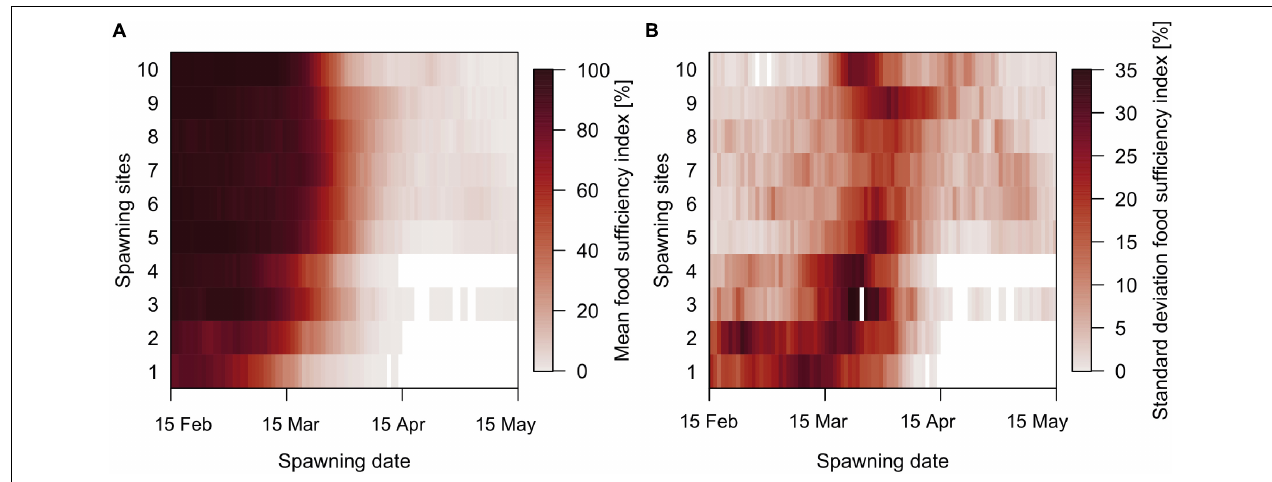
FIGURE 5 | Fraction of individuals that grow 90% or more than their temperature-dependent potential if the prey is unlimited for more than 90% of the time since hatching until the 30th of September (food sufficiency index), per spawning site and spawning date. (A) Mean and (B) standard deviation. Blank spaces represent no individuals (food sufficiency index =